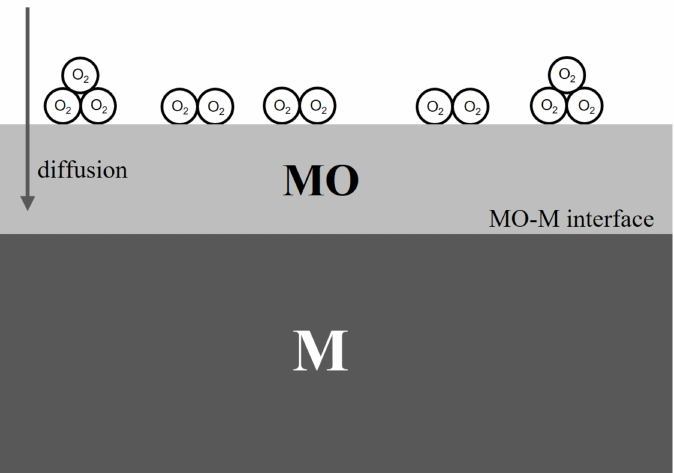
Figure 1. Diagram of gas–solid reaction.